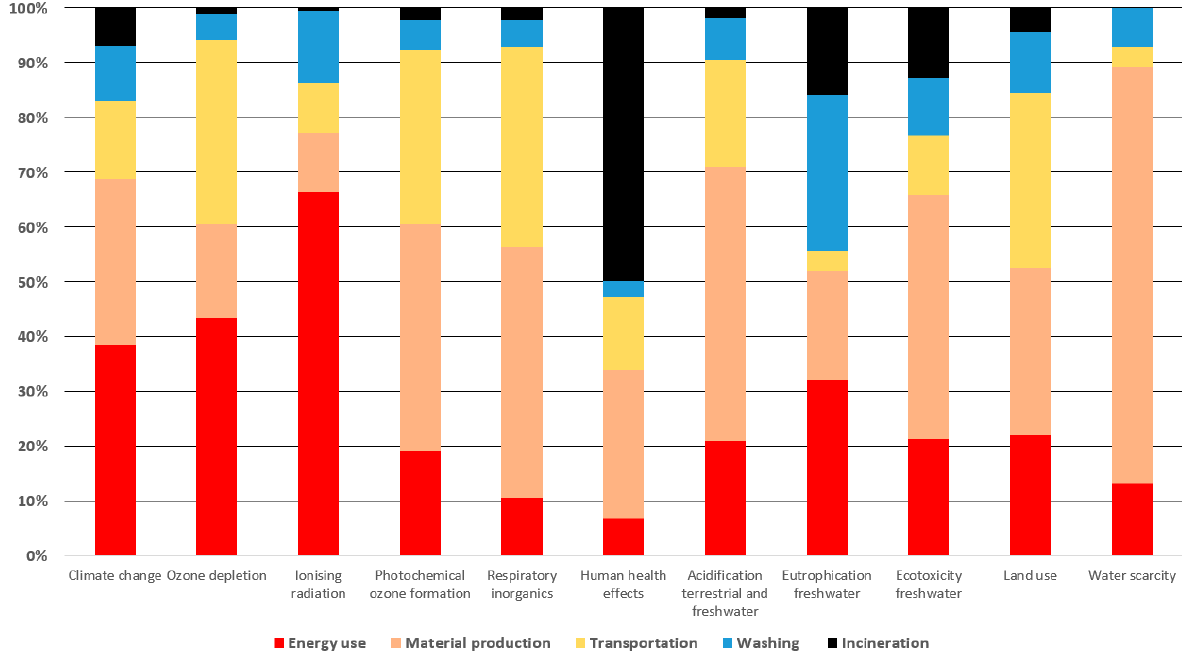
Figure 6. Relative impact shares of the five main production activities—energy use, material production, transportation, washing and incineration-along the life cycle of the linear product system.